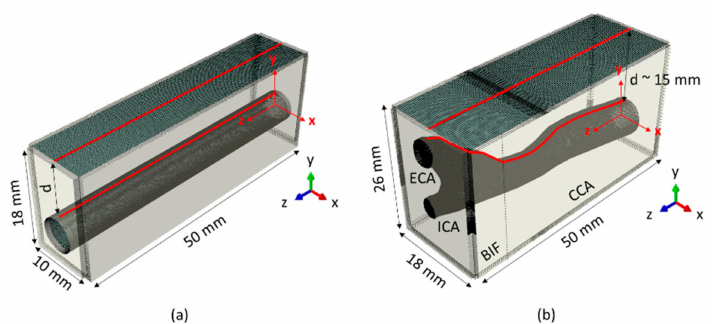
Figure 1. ( a ) Geometry of the common carotid artery (CCA) embedded within a cuboidal domain. The free (skin) surface is in dark grey, while infinite mesh elements placed on the outer boundaries are in light grey. In red are highlighted the node sets at the skin and lumen surface, where displacement data were extracted for the wave analysis. ( b ) Geometry of the patient-specific carotid artery CA embedded within a cuboidal domain. Sub regions common carotid artery, CCA; bifurcation, BIF; internal carotid artery, ICA and external carotid artery, ECA are indicated. Again, the top external surface (dark grey) is a free surface, while all the other boundaries in light grey are infinite elements. The lines in red show the paths along which the data for the wave analysis were exported. For both panel ( a , b ), the coordinate system in red indicates the actual position of the model, but for visualization purposes a view triad (located in the right corner of each panel) will be used further in the manuscript to display the view